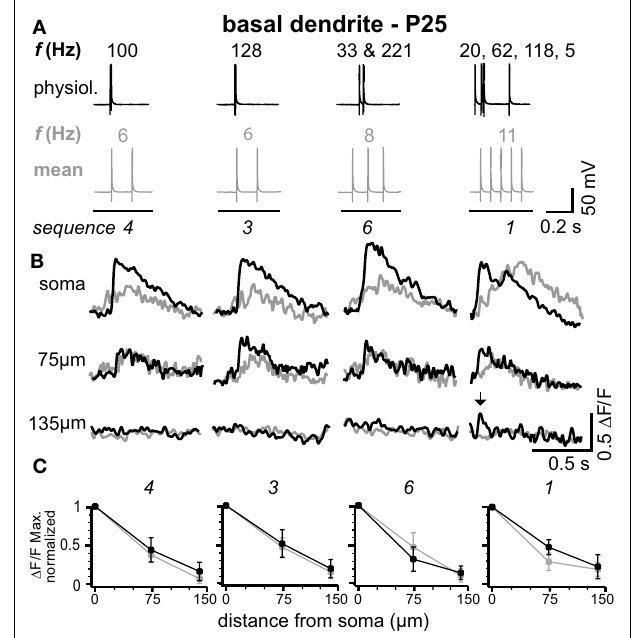
FIGURE 2 | Physiological and mean fi ring patterns decline with a similar length constant along the basal dendrites. (A) Physiological fi ring patterns (black; sequences 1, 3, 4, and 6) and the corresponding mean fi ring patterns (gray) were triggered in a L5A pyramidal neuron at P25. (B) Ca 2 + transients were measured at the soma, 75 µm, and 135 µm from soma across a basal dendrite. (C) Peak amplitudes of Ca 2 + transients ( Δ F/F max, normalized) are plotted as function of distance from soma. Data are given as mean ± sem ( n =